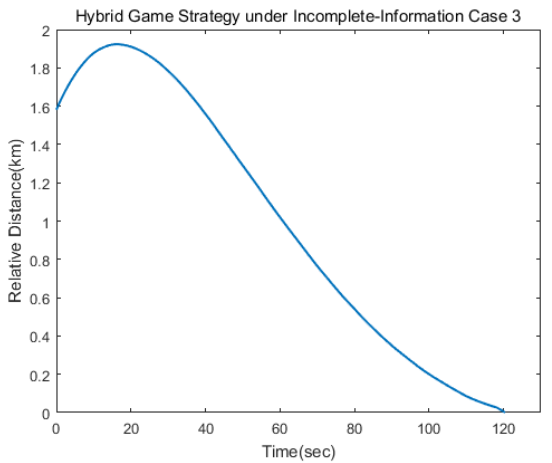
Figure 18. Relative distance between the pursuer and the target.